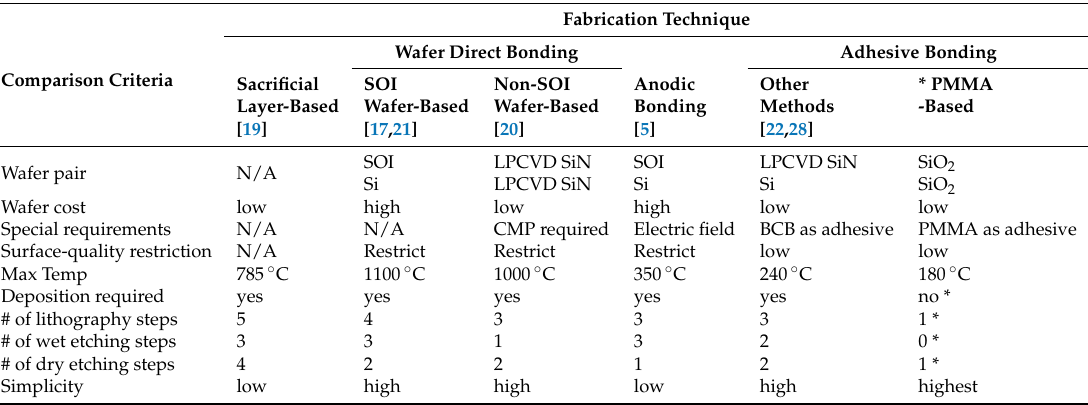
Table 2. Comparison of fabrication